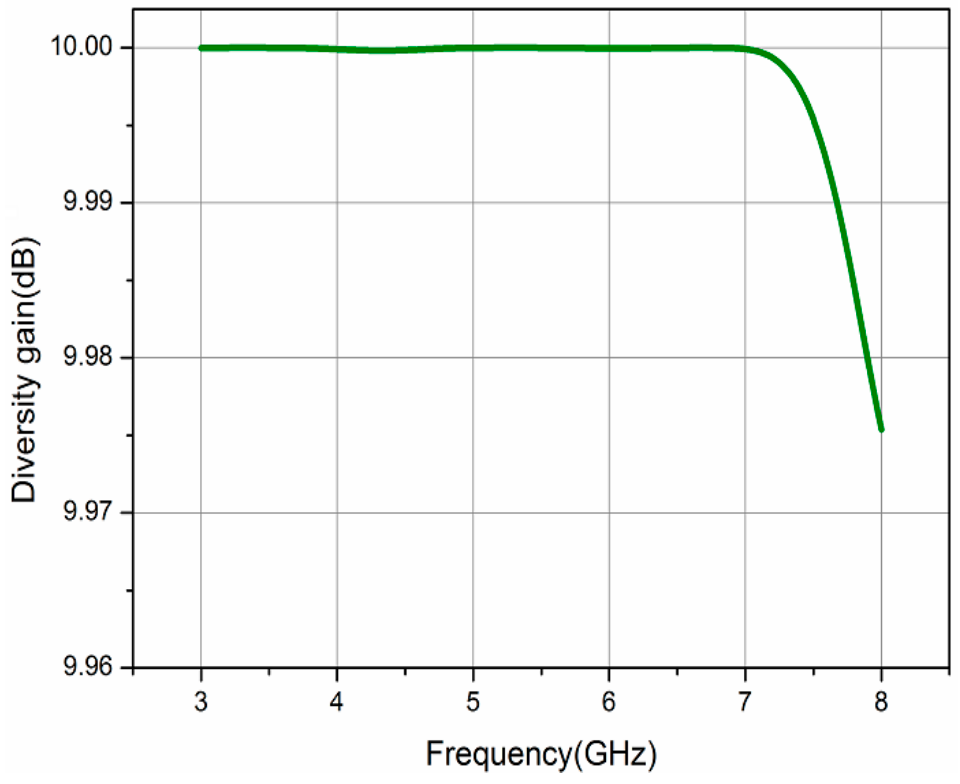
Figure 11. Simulated diversity gain.